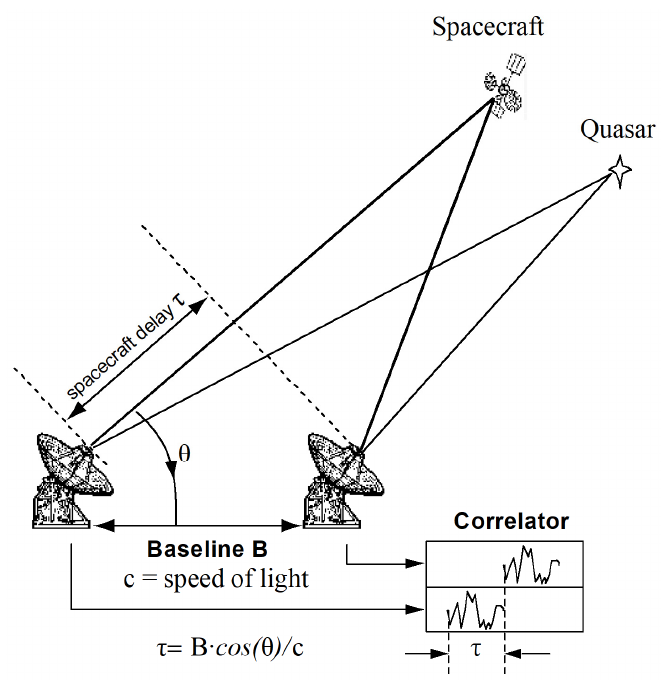
Figure 2. DeltaDOR Observation Geometry.